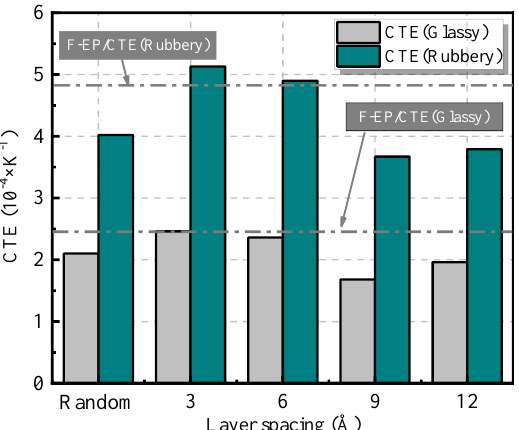
Figure 5. Coefficient of thermal expansion of FGO/F ‐ EP composites with different distribution characteristics.